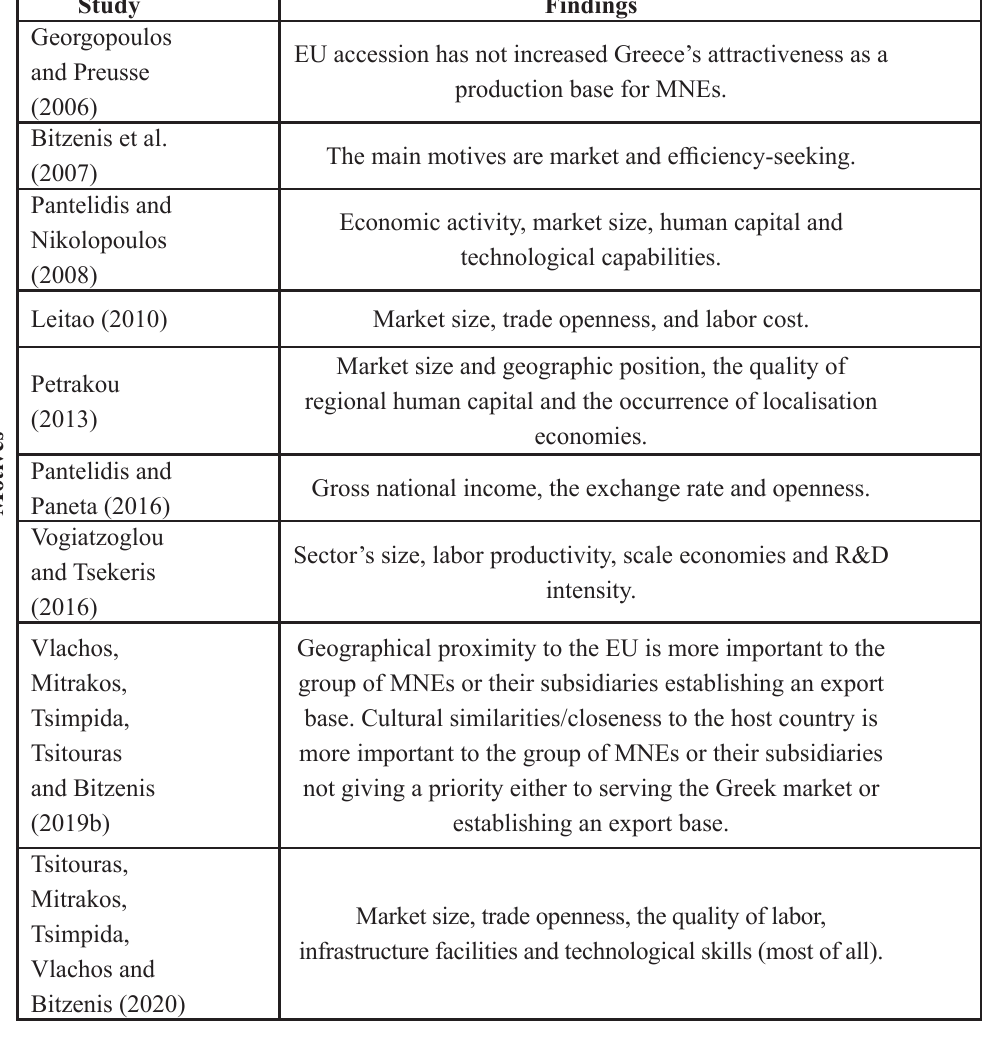
Table 1: Motives and Barriers to Greece’s Inward FDI Study